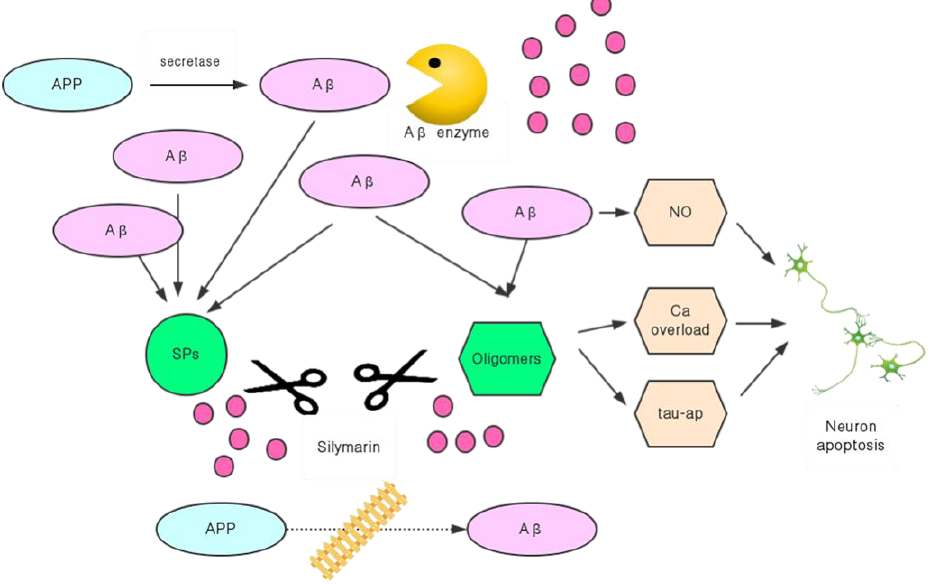
Figure 3. Inhibition of silymarin on Aβ-induced AD process.